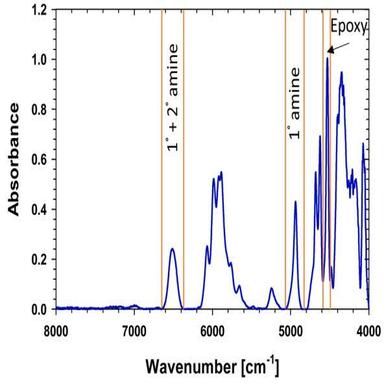
Absorbance spectrum of the Epon 828/MXD system containing 2% nonylphenol obtained using a benchtop spectrometer (Bruker Equinox 55). Peaks of interests are marked with vertical lines.